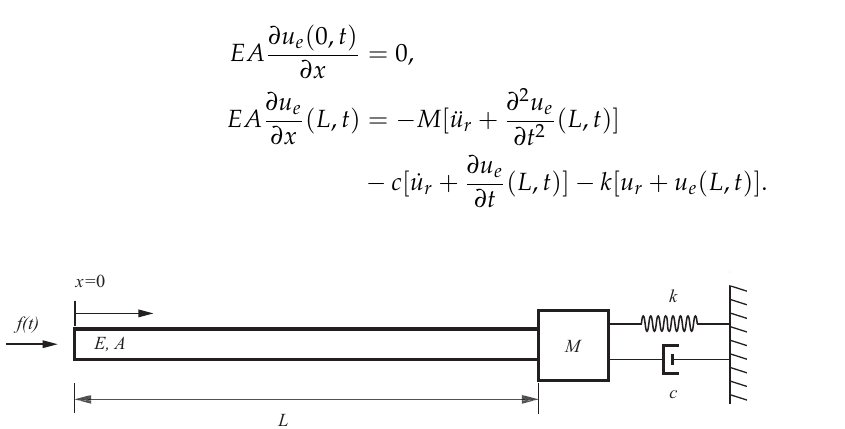
Figure 1. A uniform elastic rod with a mass–damper–spring termination. An impact loading f ( t ) is applied to the free end. The material coordinate system is fixed to the free end of the